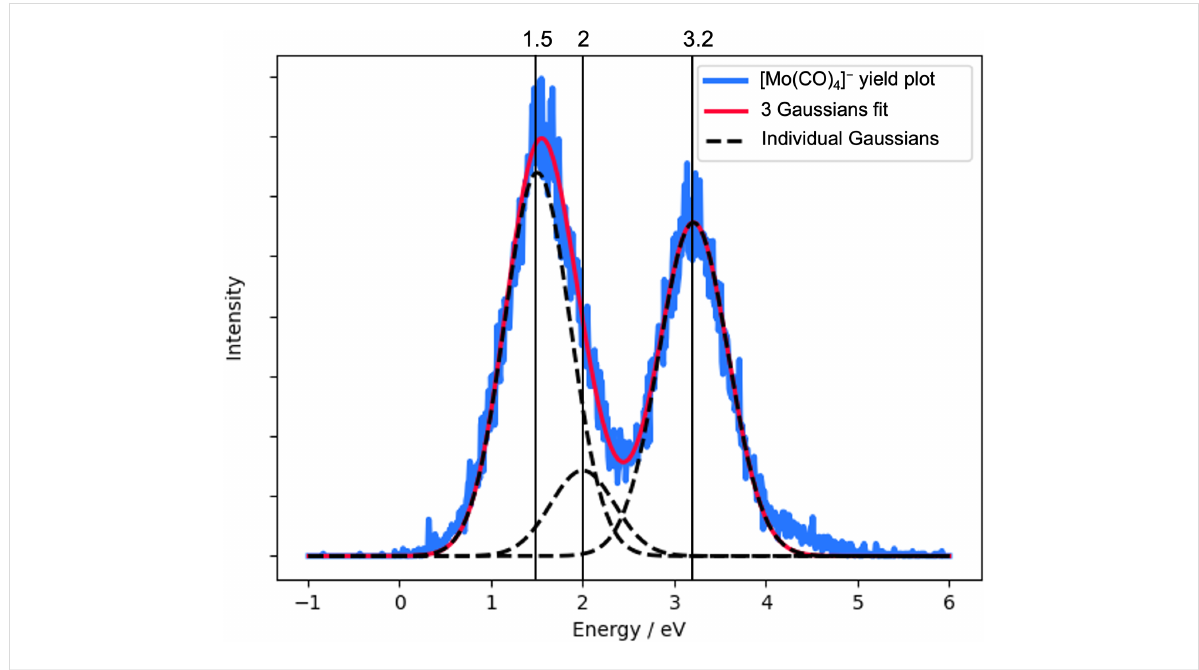
Figure 2: Fit to the [Mo(CO) 4 ] − ion yield using three Gaussian functions to represent the 1.65, 2.14 and 3.29 eV resonances observed in the ETS from Giordan et al. [18] ( R 2 = 0.98).